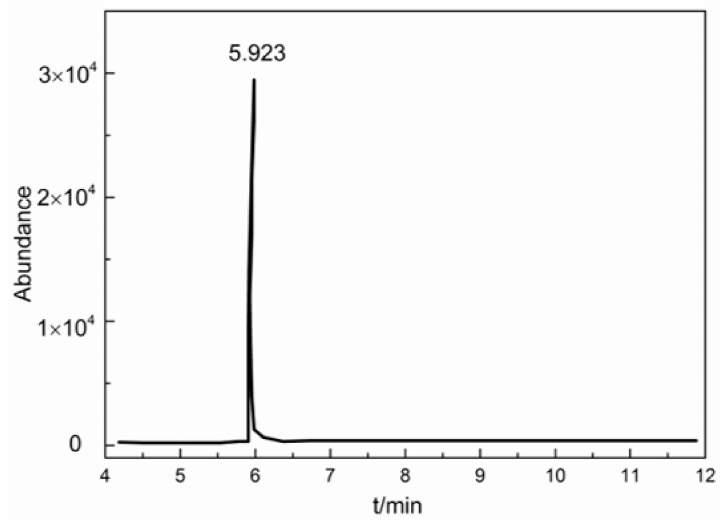
Figure 2. The TIC of